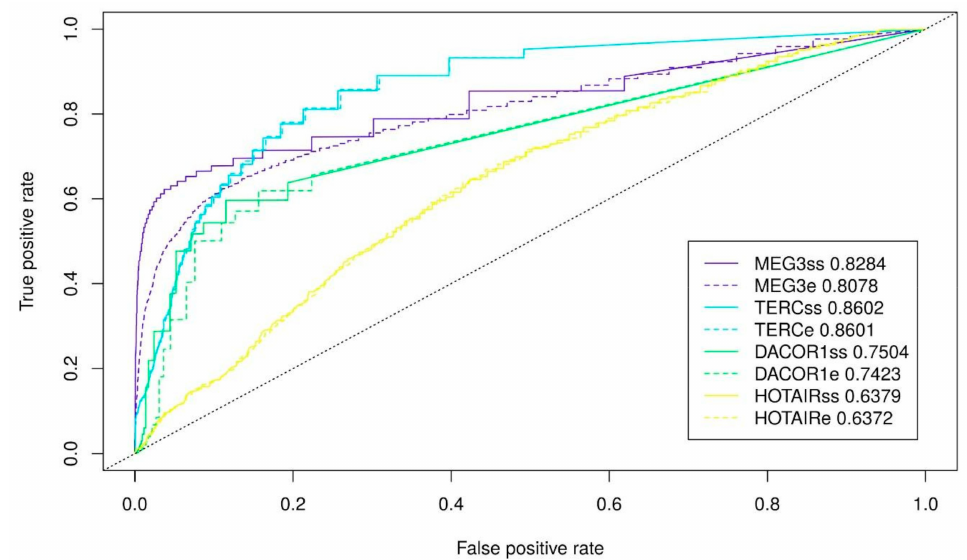
Figure 4. ROC-curves for the best cases of triplexes prediction and corresponding AUC. MEG3ss, and MEG3e stand for single-stranded fragments and the entire MEG3, respectively (l10e20g40, RNAplfold pairing probability 0.5). TERCss and TERCe stand for single-stranded fragments and the entire TERC, respectively (l10e20g70, RNAplfold pairing probability 0.95). DACOR1ss and DACOR1e stand for single-stranded fragments and the entire of DACOR1, respectively (l10e20g70, RNAplfold pairing probability 0.95). HOTAIRss and HOTAIRe stand for single-stranded fragments and the entire HOTAIR, respectively (l10e20g40, RNAplfold pairing probability 0.97).